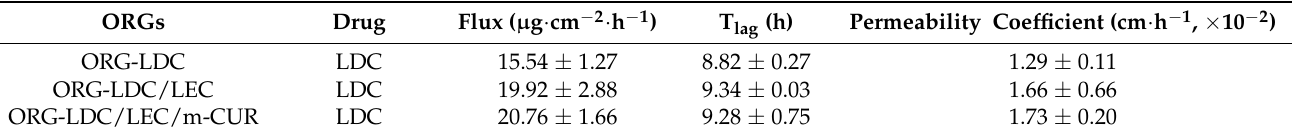
Table 5. Lidocaine hydrochloride (LDC) permeation parameters across the Strat-M ® membrane.